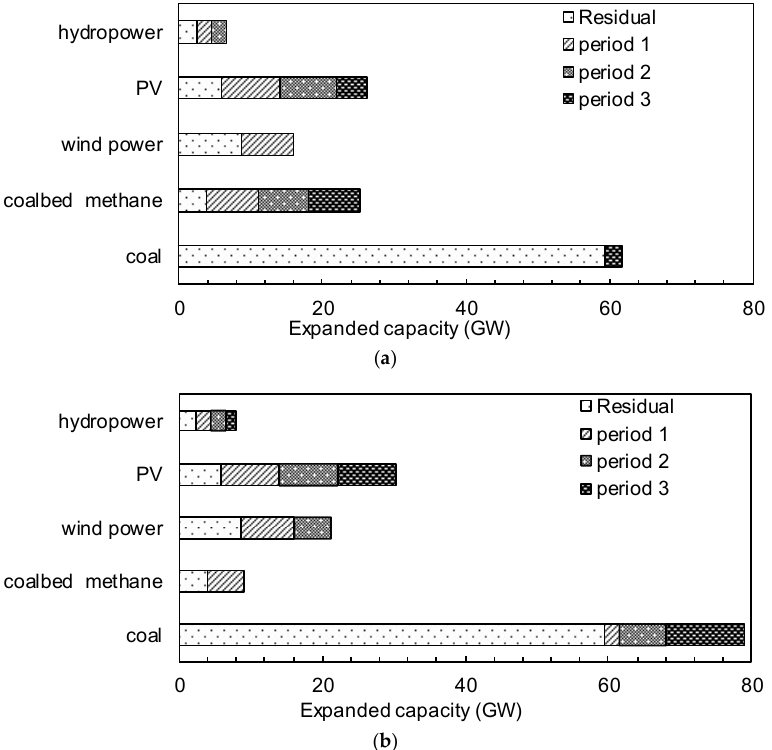
Figure 7. Solution for capacity expansion. ( a ) Fuzzy chance-constrained fractional programming (FCFP) model; and ( b ) least-system-cost model.